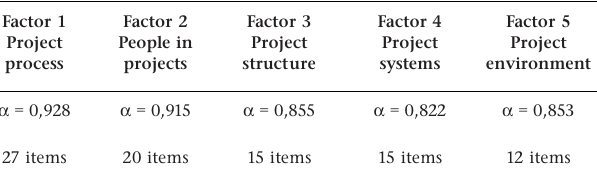
After the completion of the exploratory factor analyses and the elimination of items confirmatory factor analysis was done on each scale. The results did not confirm that the scales were independent, which could be expected from an interdependent construct of items. A final item analysis was done on the 89 remaining items per factor root for each of the five-factor scales. The results of the final item analysis as illustrated in Table 9 show that all the items have a total item correlation of > 0,32, which indicates that the items in the final tool have a high